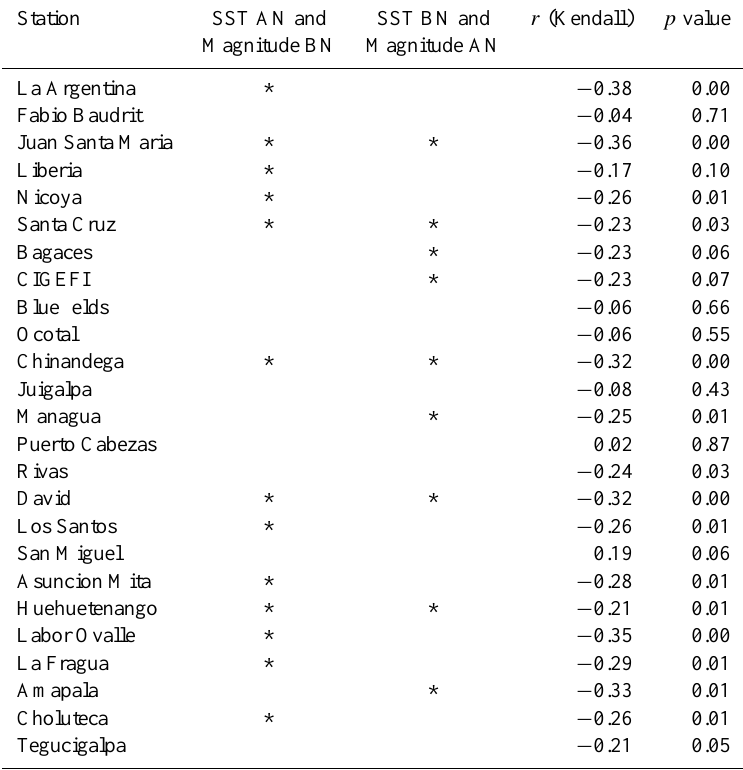
Table 3. Same as Table 2 but for MSD magnitude.